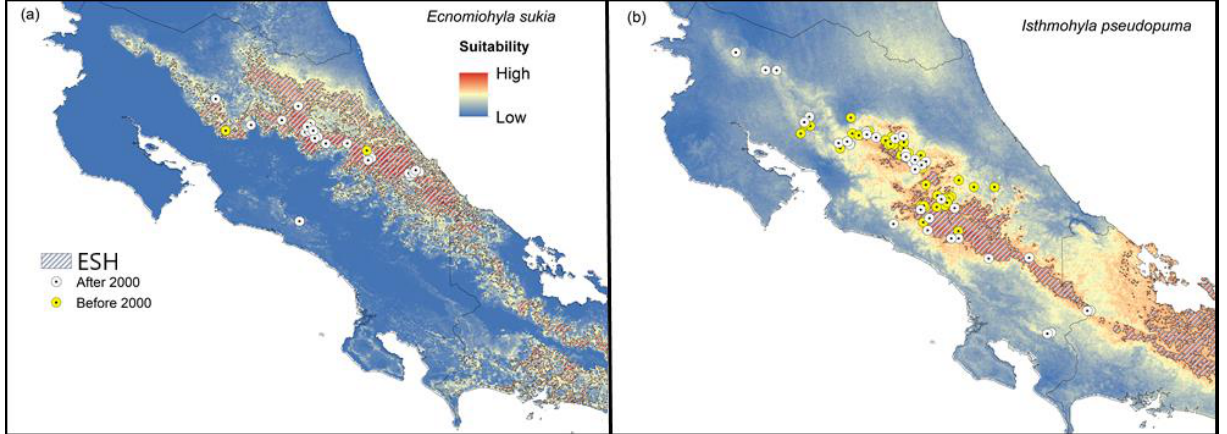
Figure 4. Widespread uncommon species and rapid-spread species. Climatic suitability maps for the uncommon and widespread ( a ) Shaman fringe-limbed treefrog ( Ecnomiohyla sukia ) and ( b ) the potential Bd -reservoir Gunther’s Costa Rican treefrog ( Isthmohyla pseudopuma ). The figure also shows a polygon representing the historic extent of suitable habitat (ESH), occurrences reported after 2000 (white dots), and locations where the species was found before 2000 but not after (yellow dots).